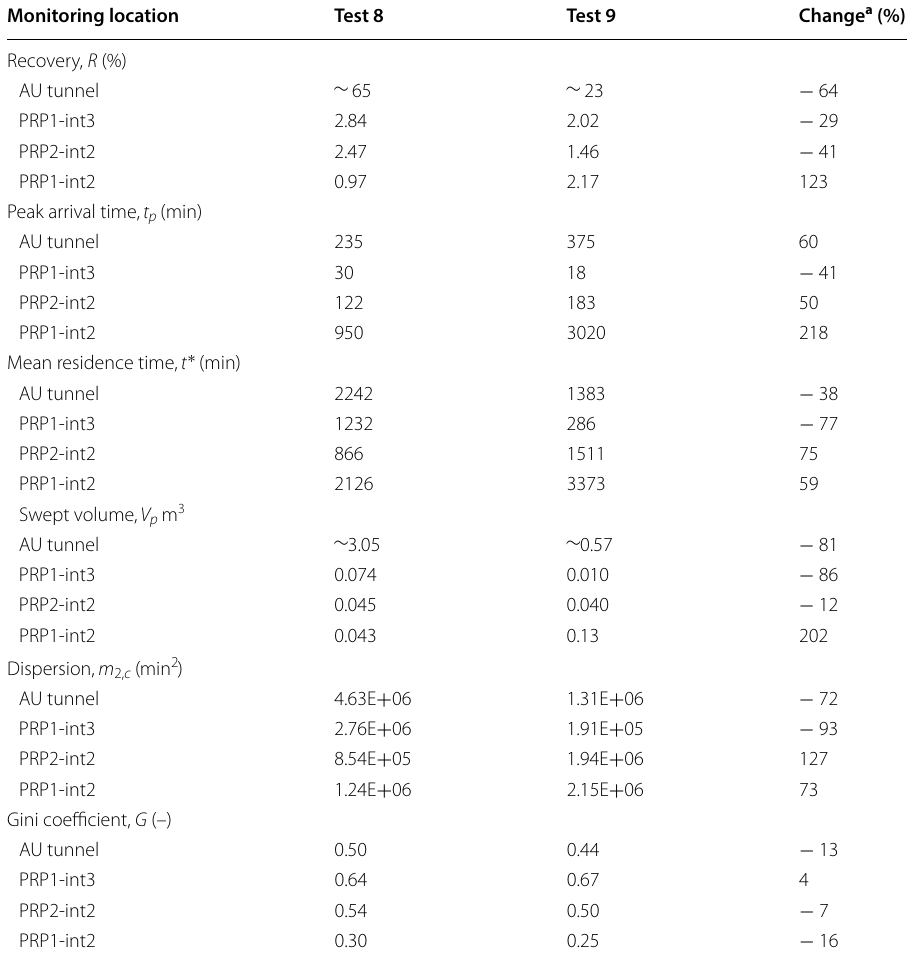
Table 2 Summary of the tracer transport